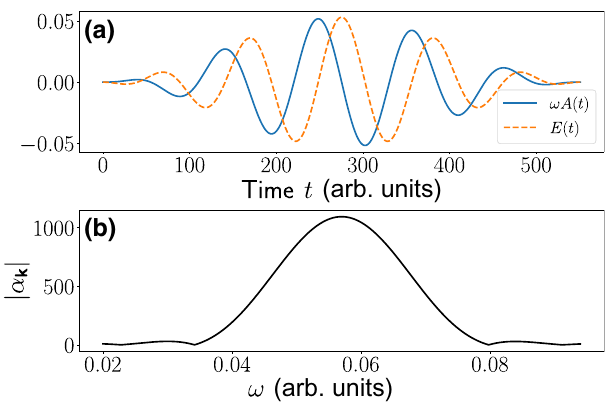
FIG. 3. In (a) we consider a linearly polarized electromagnetic field with a sinusoidal squared envelope, central frequency ω = 0.057 a.u., field amplitude E = 0.053 a.u., and n cyc = 5 cycles. The orange dashed curve shows the electric field while the blue solid curve the vector potential. In (b) we show the dependence of | α k , μ | on the frequency